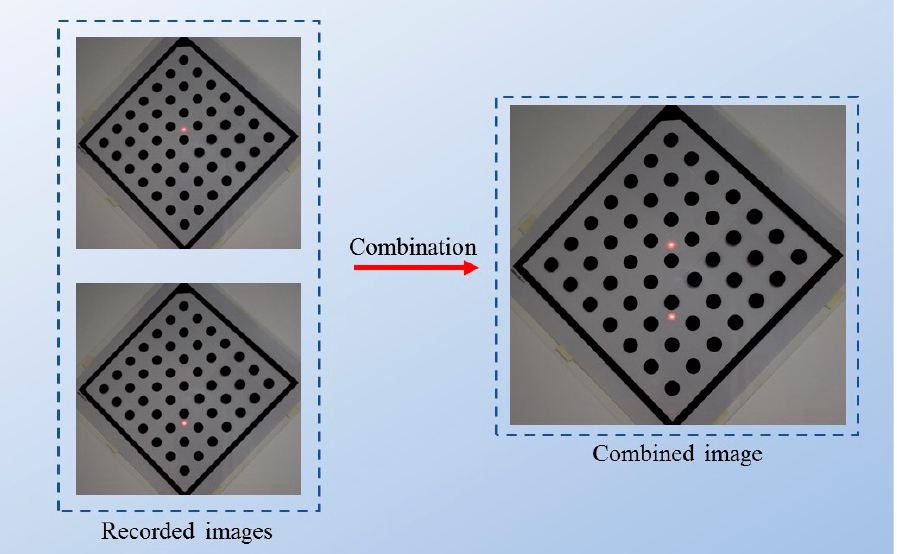
Figure 4. Combination of the recorded images.